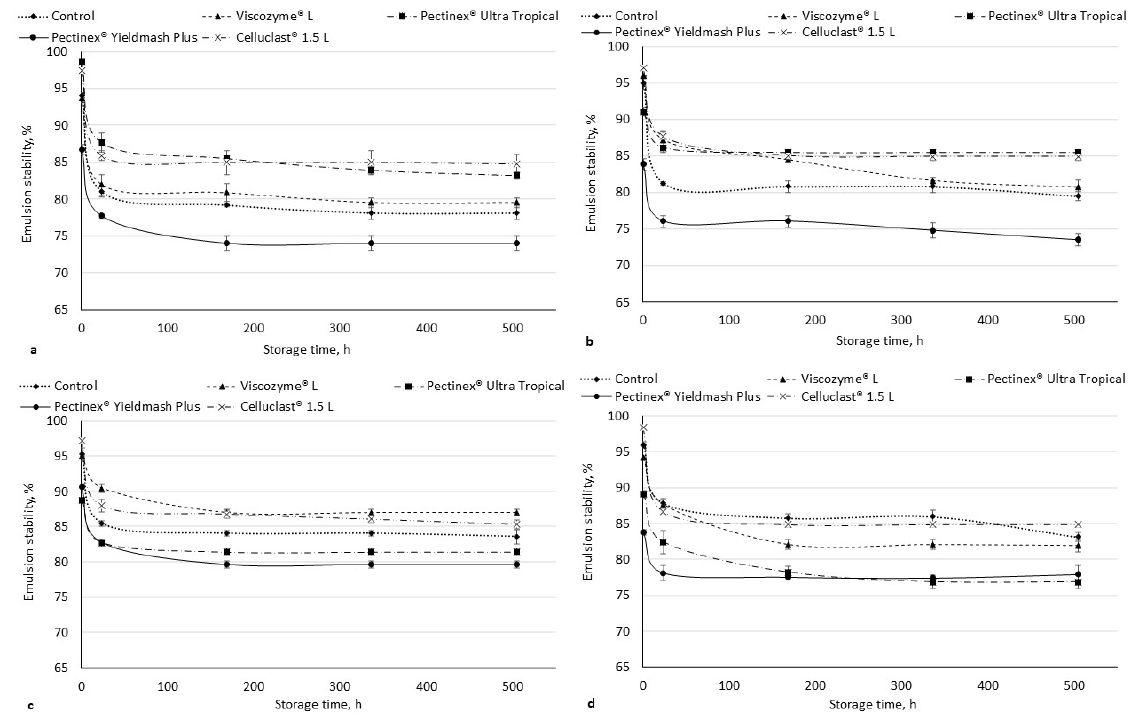
Figure 1. Emulsion stability of enzymatically hydrolyzed cranberry pomaces at pH 3.27 (water) ( a ); 4 ( b ); 6 ( c ); 8 ( d ). Data values are expressed as means with the standard deviation ( n = 3).